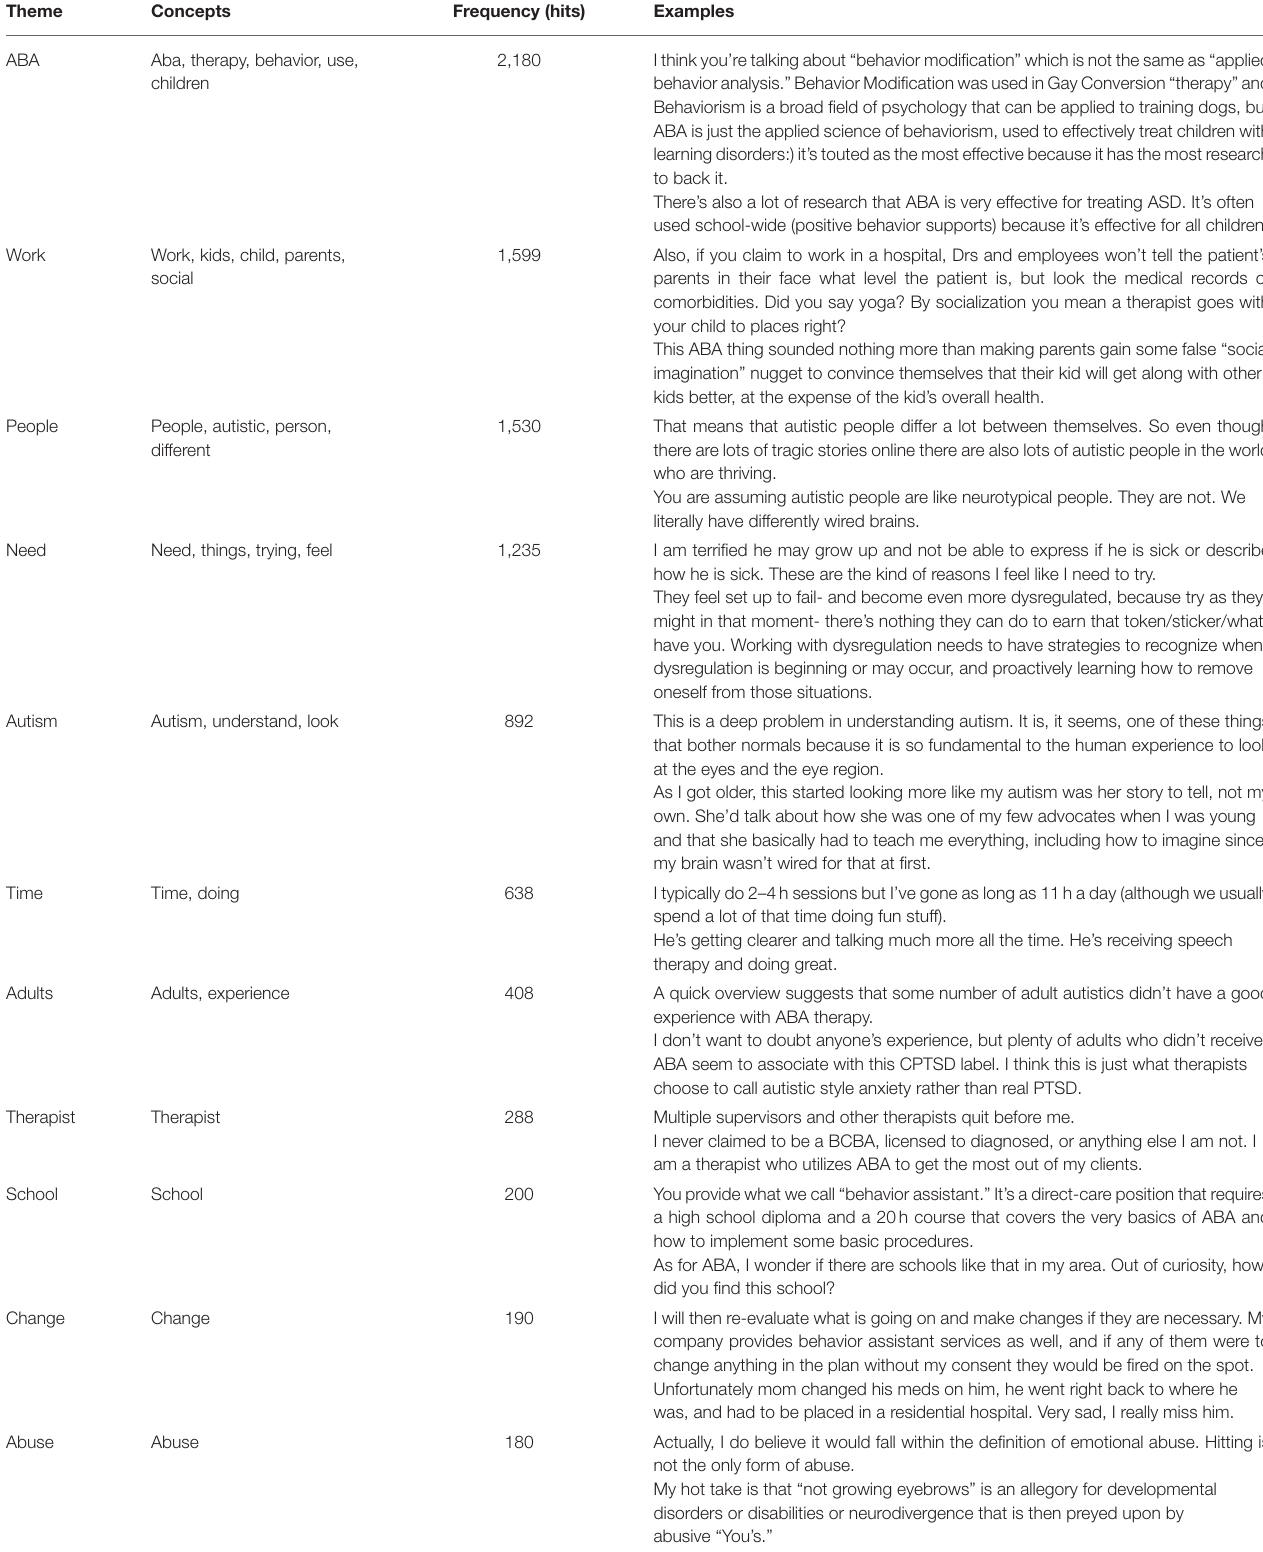
TABLE 2 | Main themes and concepts in discussions around